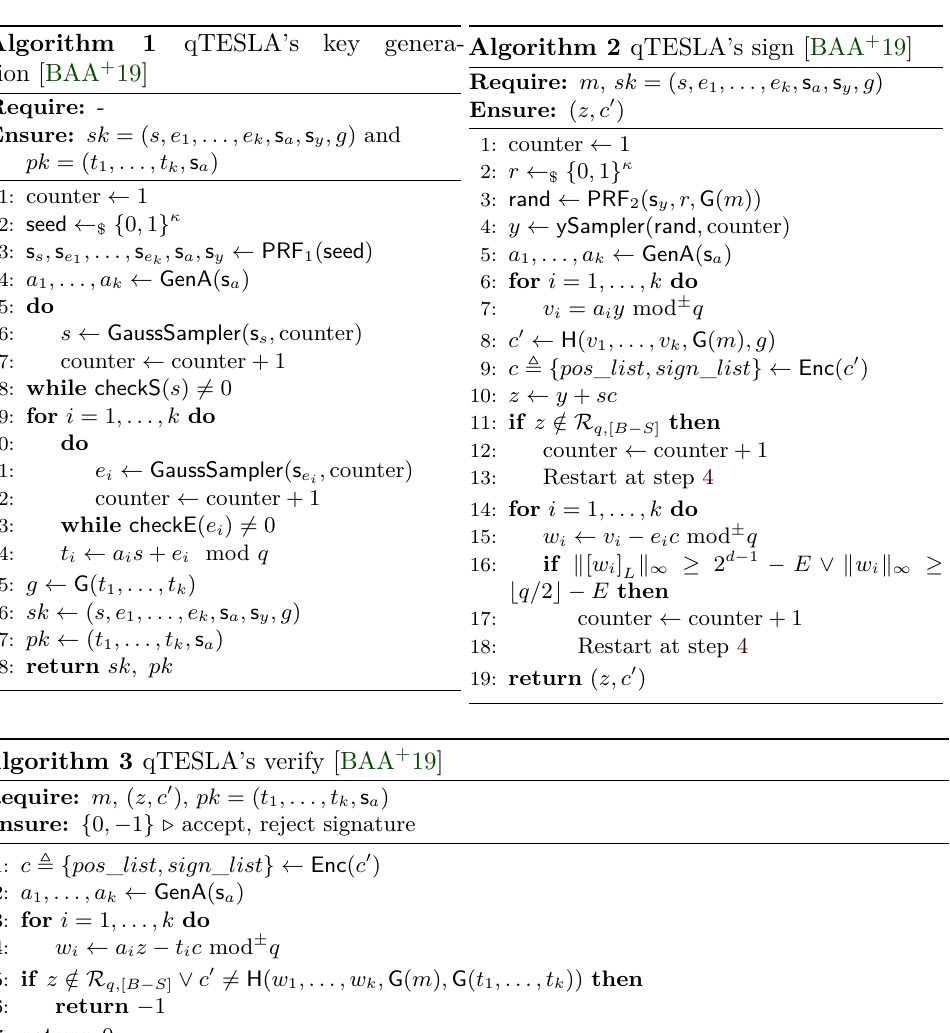
Algorithm 3 qTESLA’s verify [BAA +